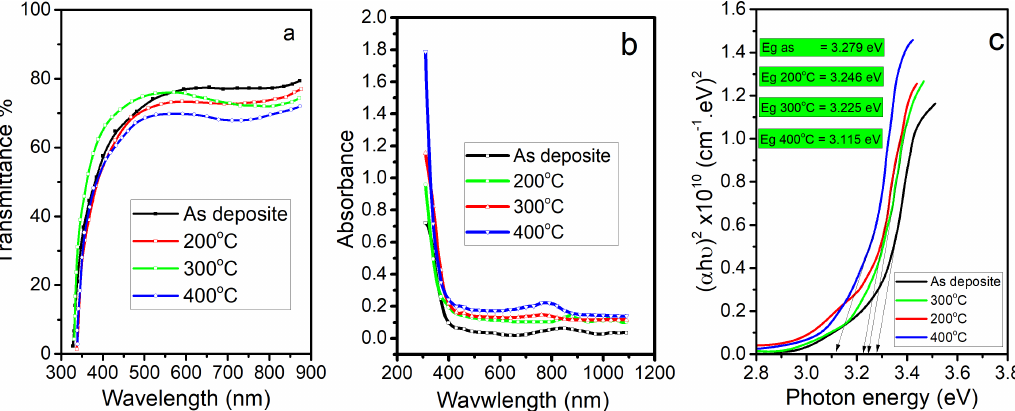
Figure 4: (a and b) The transmittance and absorbance spectra, respectively, as a function of the wavelength, (c) ( α h υ ) 2 as a function of the Photon energy of TiO at different annealing